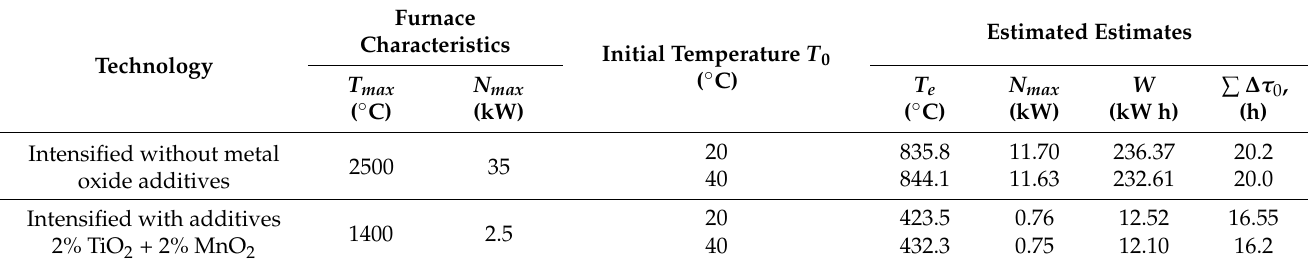
Table 5. General characteristics of thermal cycles at different values of their initial